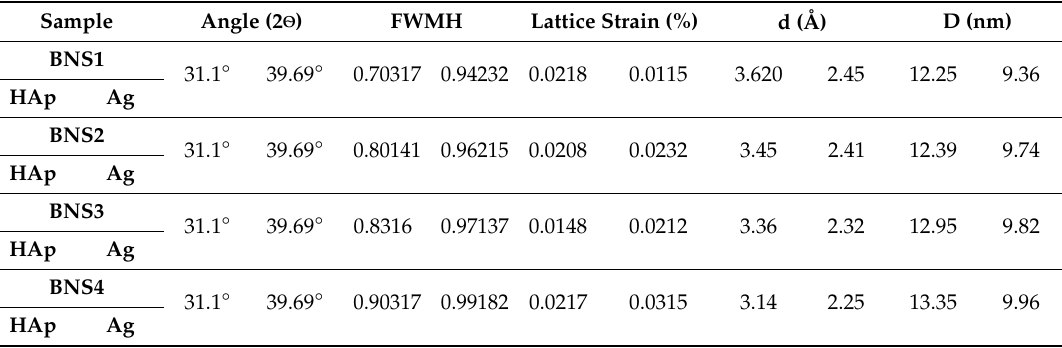
Figure 3. X-ray di ff raction (XRD) spectra of BNS samples. Figure 3. X-ray diffraction (XRD) spectra of BNS samples. Table 2. Calculated parameters of prepared BNS samples. Table 2. Calculated parameters of prepared BNS samples.